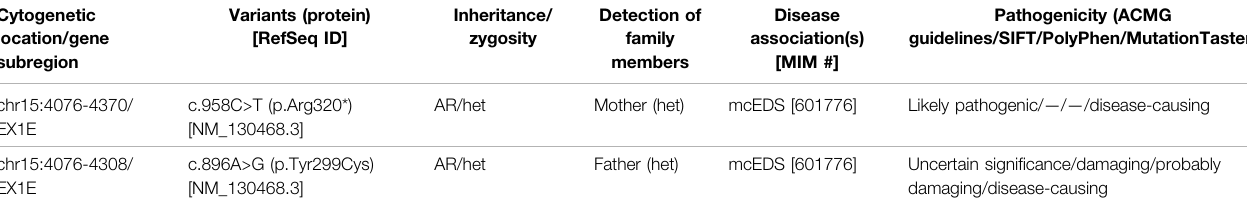
Frontiers in Genetics |